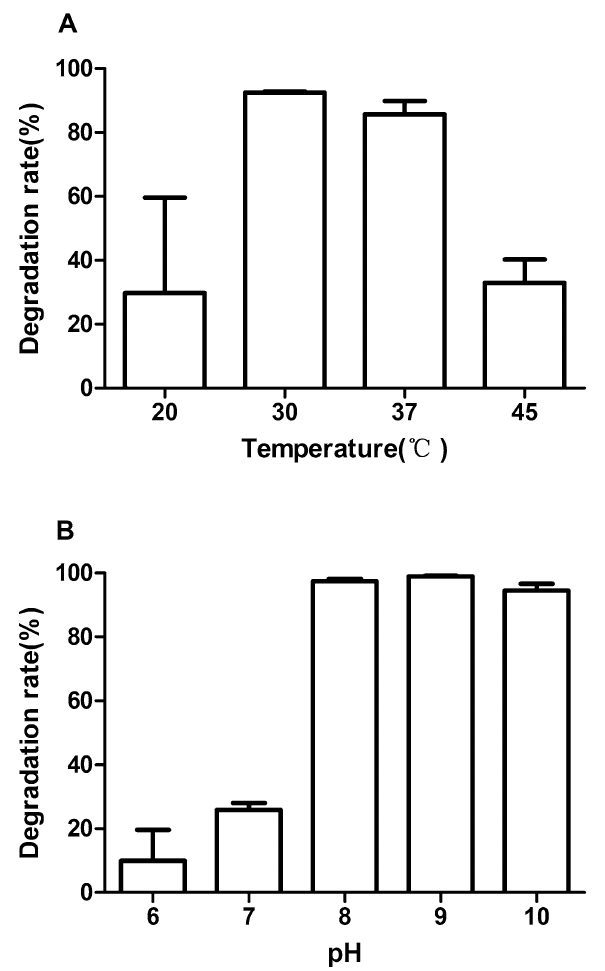
Figure 2. Extent of DEHP degradation by strain LMB-7 under different conditions for 24 h incubation. ( A ) Degradation of DEHP at different temperatures; ( B ) Degradation of DEHP at different pH. Data are the mean ± SD of three independent